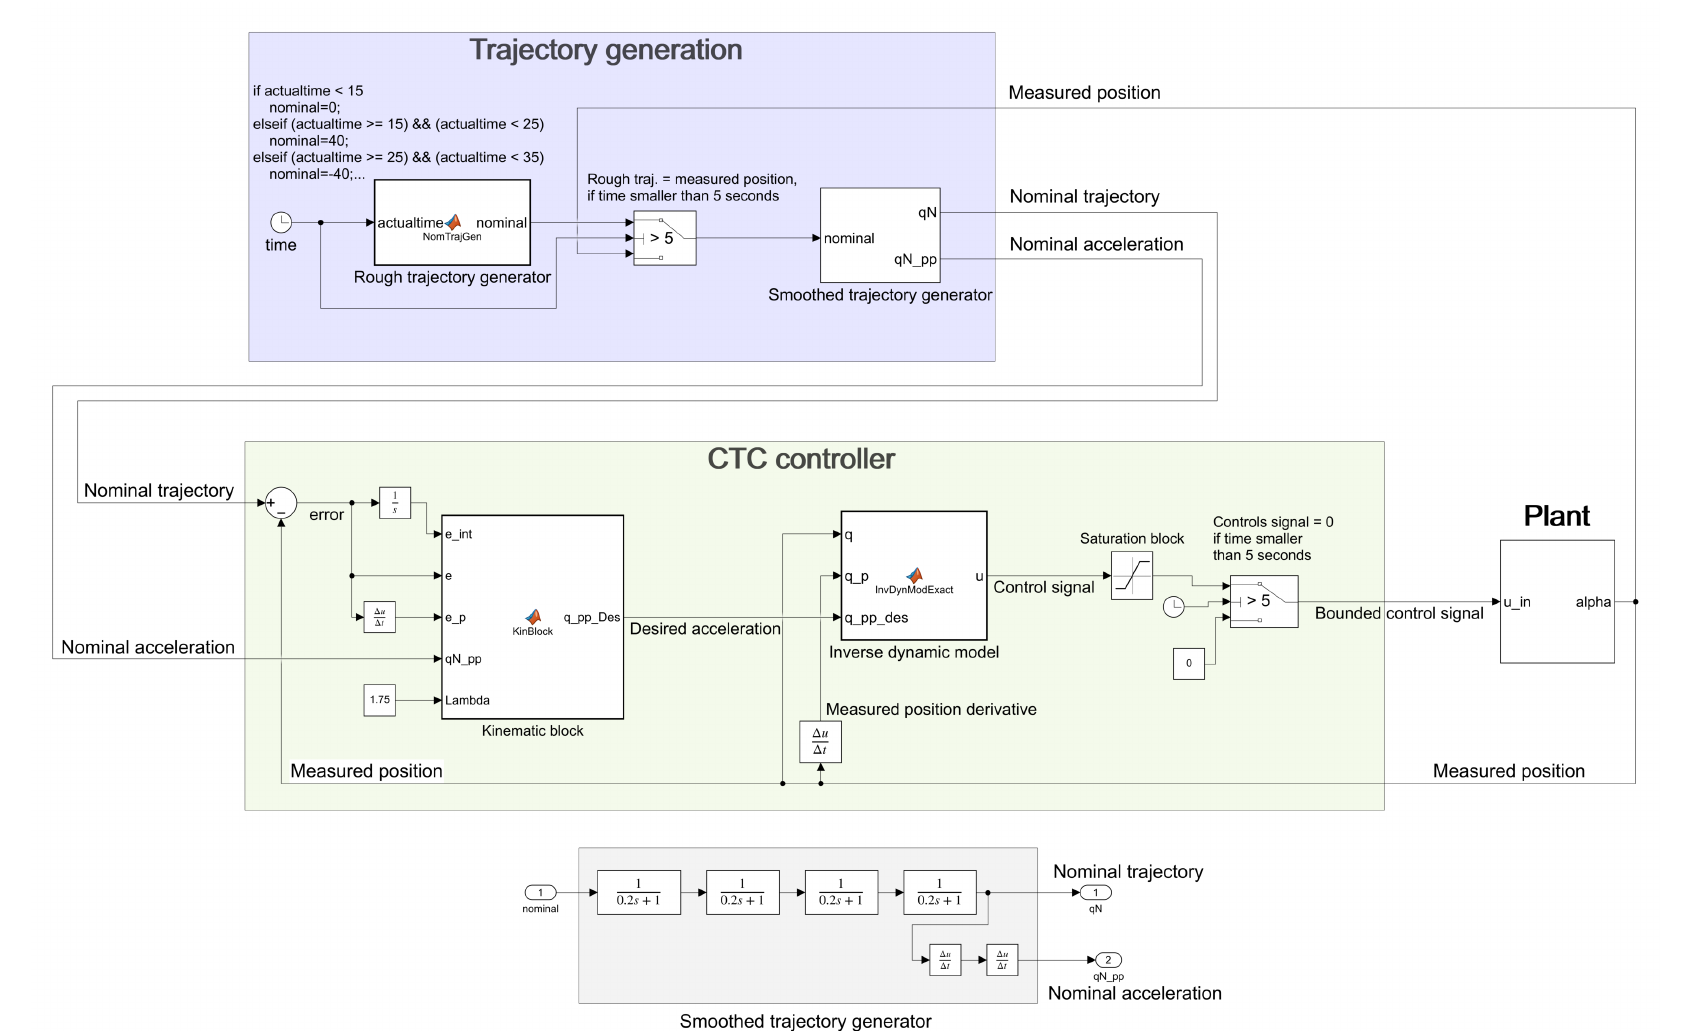
Figure 7. Details of the realized CTC control scheme modeled in Matlab